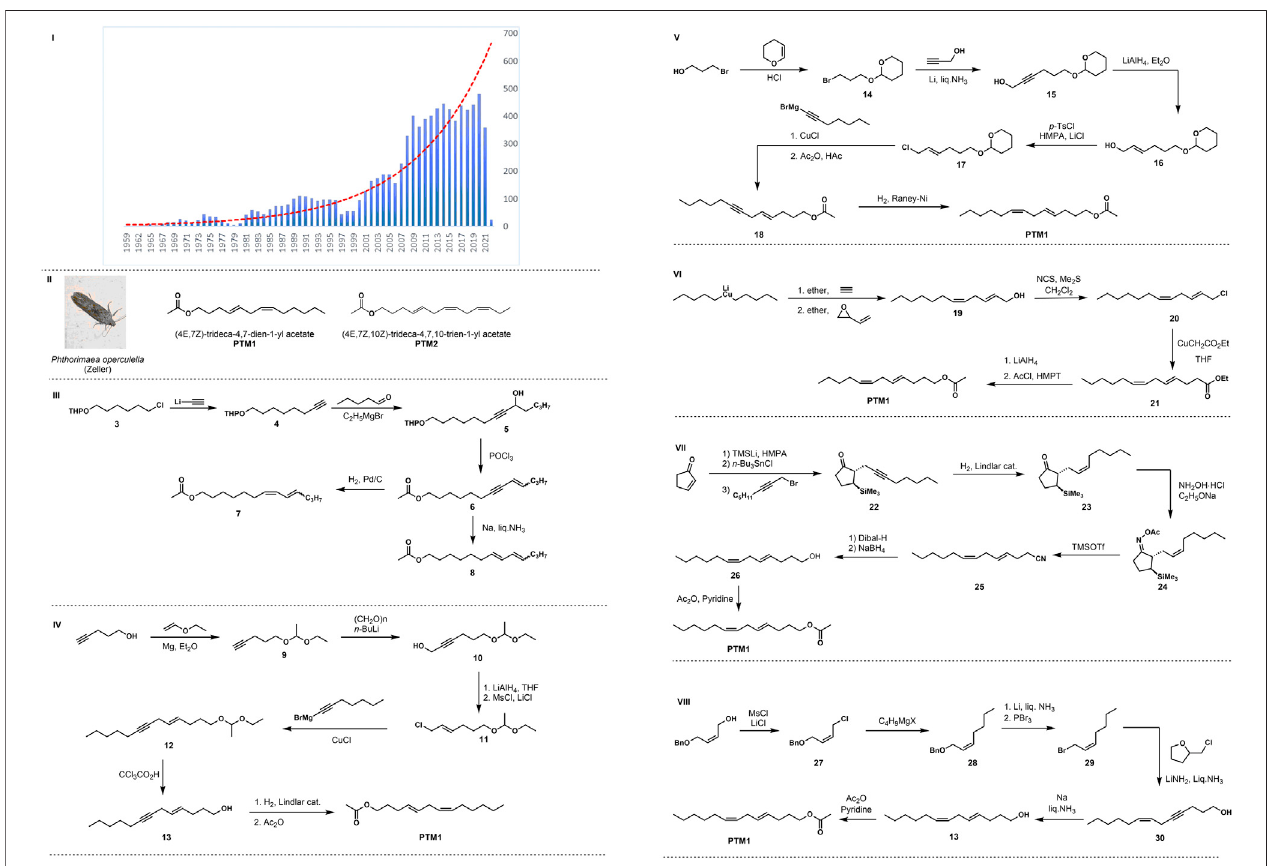
FIGURE 1 | I Statistics of the number of research papers on insect sex pheromone from web of science . II Chemical structure of sex pheromone of potato tuber moth. III SynthesisofsexpheromoneanaloguesofpotatotubermothbyFoudain1975. IV Roelofs ’ synthesisofPTM1in1975. V Voerman ’ ssynthesisofPTM1in1978. VI Alexakis ’ s synthesis of PTM1 in 1978. VII Nishiyama ’ s synthesis of PTM1 in 1984. VIII Yadav ’ s synthesis of PTM1 in